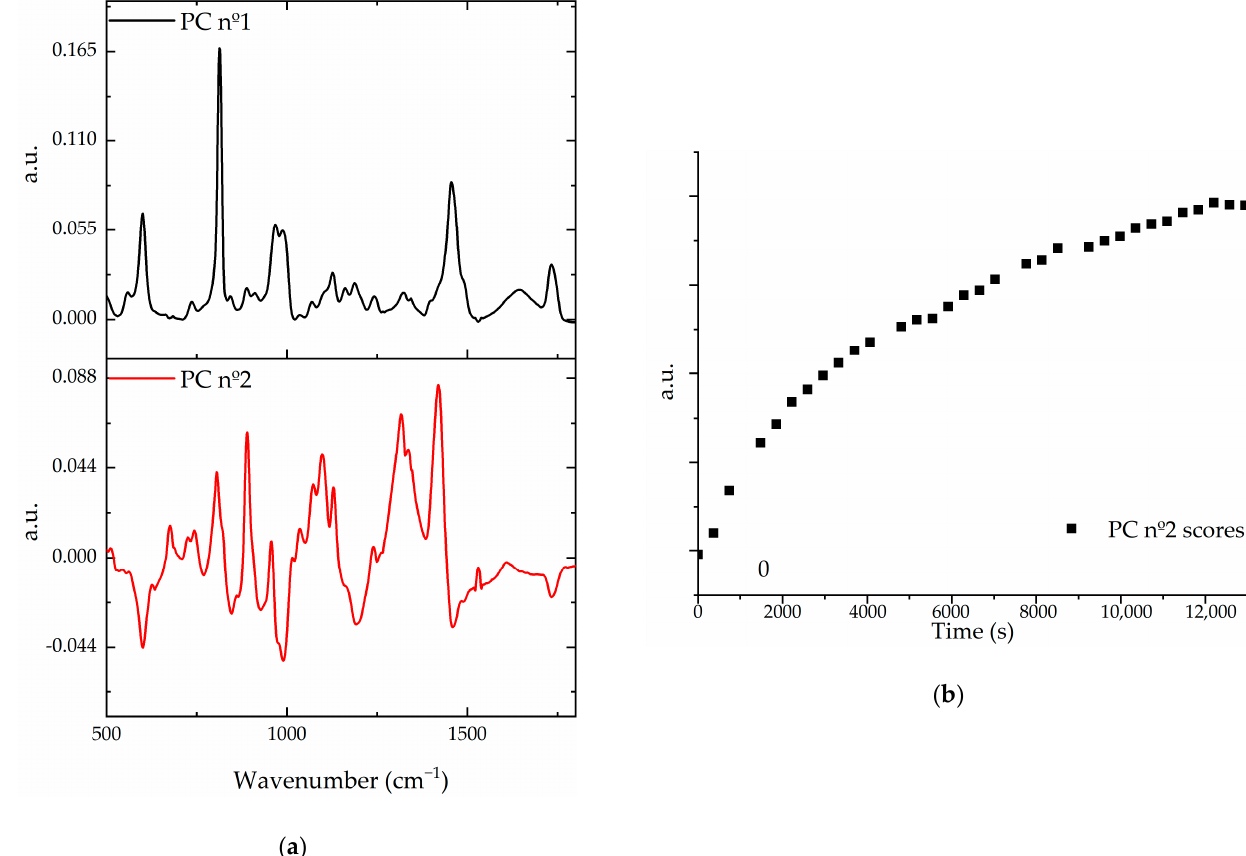
Figure 4. ( a ) The spectral shapes of the first and the second principal components (PC nº1 and nº2, respectively) of the PCA model that describes the hydrogel creation; ( b ) The temporal evolution of the scores corresponding to the PC nº2.